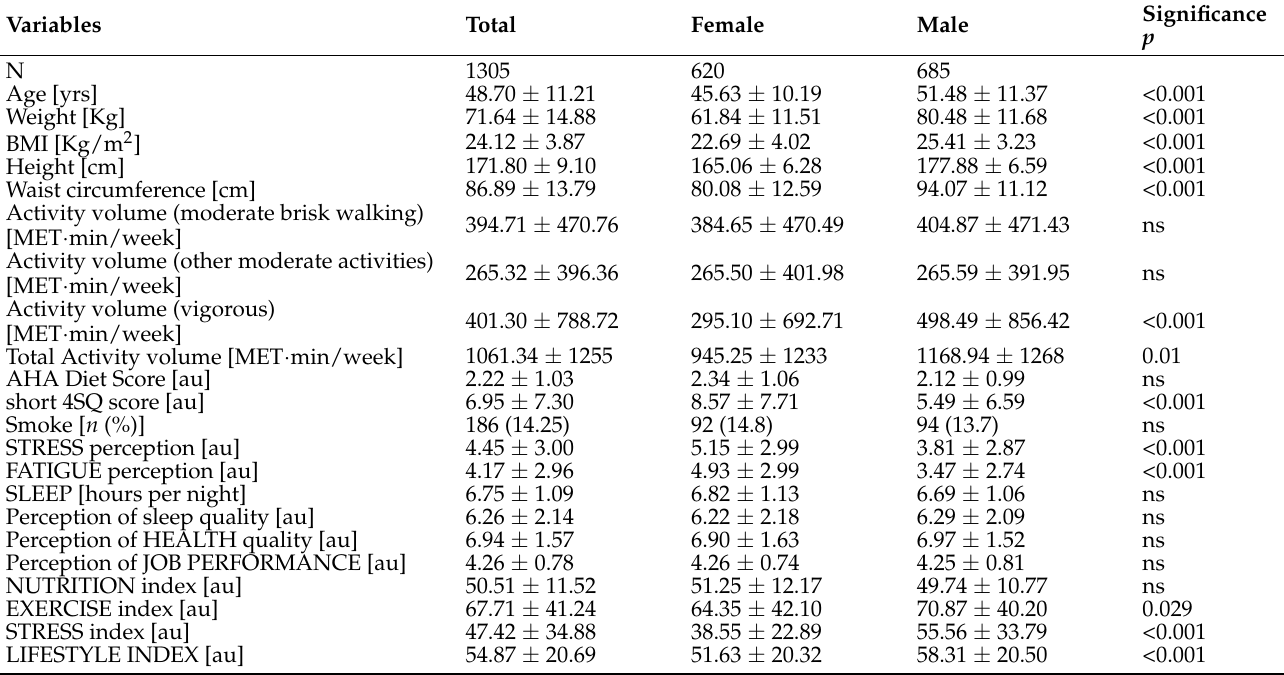
Table 1. Anthropometric and lifestyle data collected in all subjects (total) and in female and male subgroups.